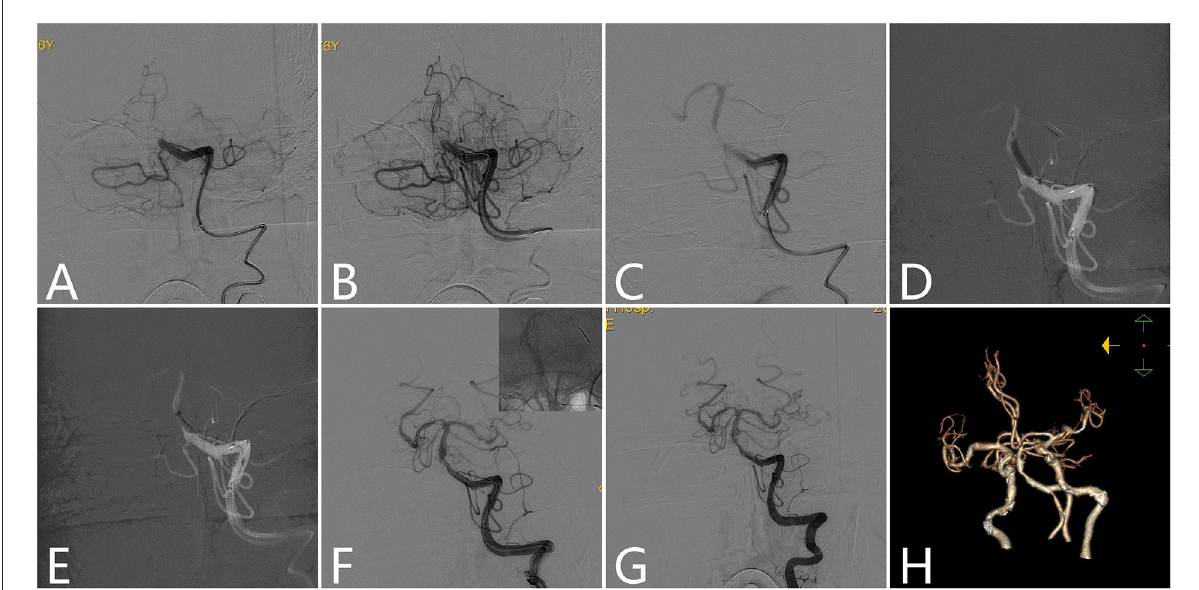
FIGURE2 Illustrative case of BASIS technique. A 76-year-old male patient presented with dizziness for 5h and sudden onset of unconsciousness and quadriplegia for 3h. The admission NIHSS score was 35, and the GCS score was 5. (A) Left vertebral angiogram showed proximal BA occlusion. (B) Microcatheters and microwires completely passed through the occlusion site. Microcatheters were retrieved to the proximal segment of the occlusion site while microwires were kept in place, and angiograms showed slow blood flow through the occlusion site, that is there is a microcatheter first-pass effect phenomenon. (C) A Syphonet 4–30mm stent was unsheathed at the occlusion site while the distal stent was placed at the SCA. (D) A Maverick 2.5/15mm balloon was advanced over the wire of the retrieval stent into the stenotic site and partially